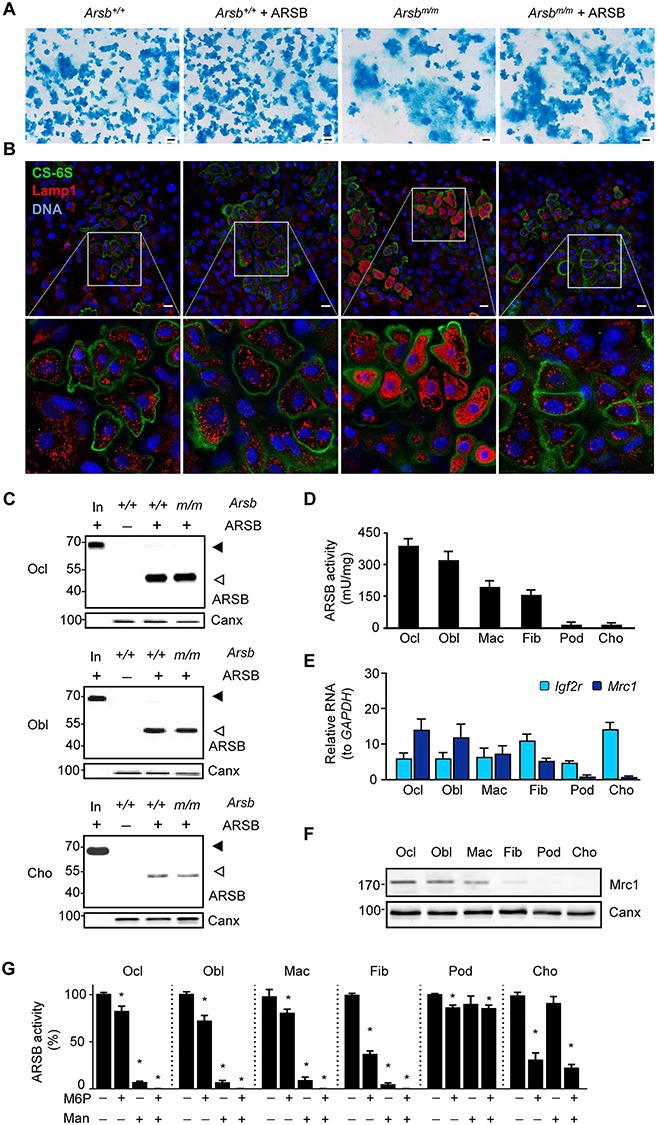
Chondrocytes have decreased capacity to endocytose rhARSB. (A) Representative images after alcian blue staining of cultured chondrocytes from wild-type (Arsb+/+) and Arsb-deficient (Arsbm/m) mice, cultured for 10 days in the absence or presence of ARSB, as indicated. (B) Immunostaining of the same cultures with antibodies against chondroitin 6-sulfate (green) and Lamp1 (red). Nuclei were visualized by DAPI stain (blue). (C) ARSB western blot of cell lysates from wild-type and Arsb-deficient osteoclasts (Ocl), osteoblasts (Obl) and chondrocytes (Cho) after incubation with ARSB for 4 h. Precursor (In, input) and mature forms of ARSB are indicated by closed or open arrowheads, respectively. Canx western blot was performed as loading control. (D) ARSB activity in cell lysates of different cell types (Ocl, osteoclasts; Obl, osteoblasts; Mac, macrophages; Fib, fibroblasts; Pod, podocytes; Cho, chondrocytes) after incubation with ARSB for 4 h (n = 6 cultures per group). (E) mRNA expression of Mrc1 and Igf2r in the same cell types (n = 6 cultures per group). (F) Mrc1 detection by western blot of the same cell types. Canx western blot was performed as loading control. (G) ARSB activity in cell lysates from the same cell types after incubation with ARSB supplemented with (+) or without (−) M6P and mannose (Man) for 4 h (n = 6 cultures per group). Data are expressed as mean ± SD.